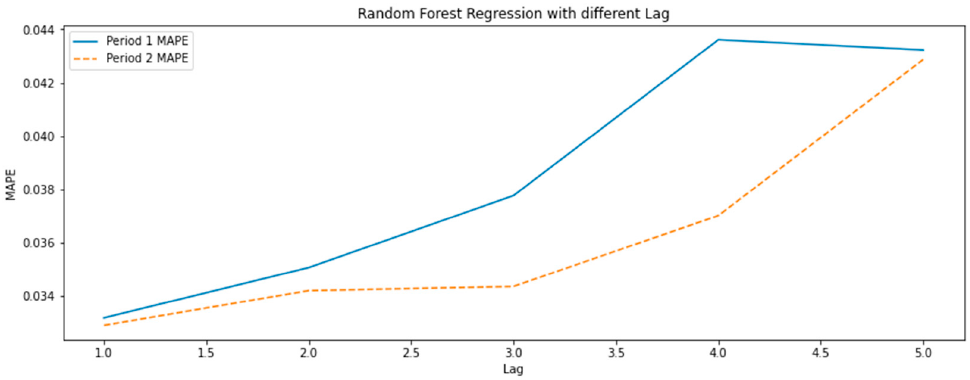
Figure 13. Relationship between MAPE and the number of lags (random forest